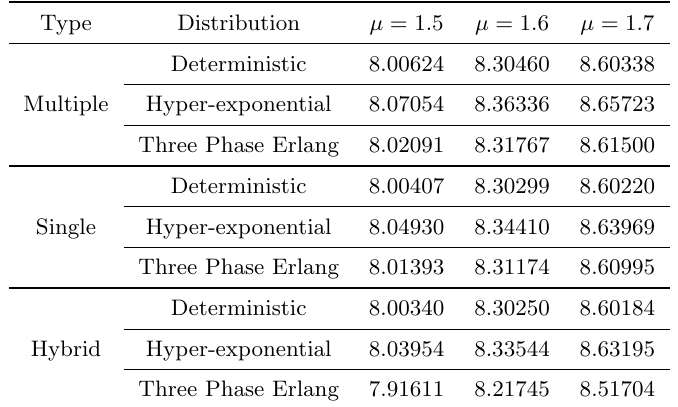
Table 3: Mean response time for the M/G/ 1 / 3 /V time